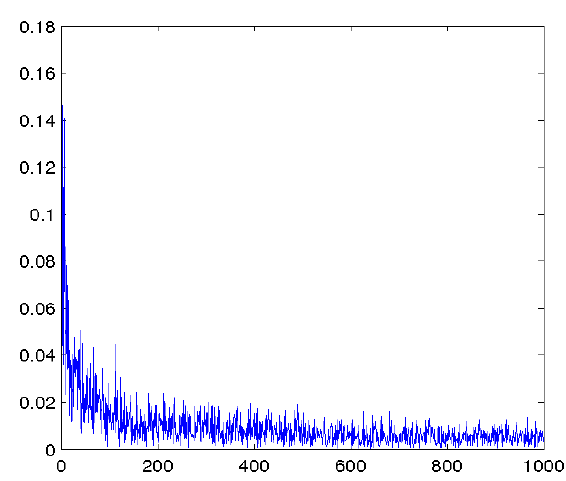
Figure 13: Simulation of the degree of recurrence D ( g N ) of the expanding map g , depending on N , on the grids E N with N = 128 k , k = 1 , ··· ,